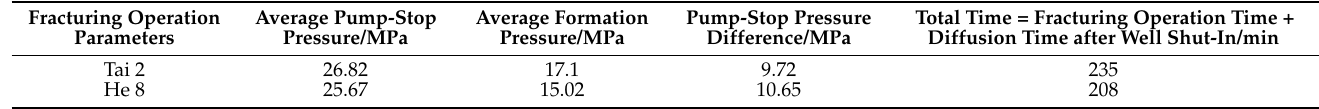
Table 2. Statistics of the imbibition pressure and time in different formation layers of the Linxing tight gas